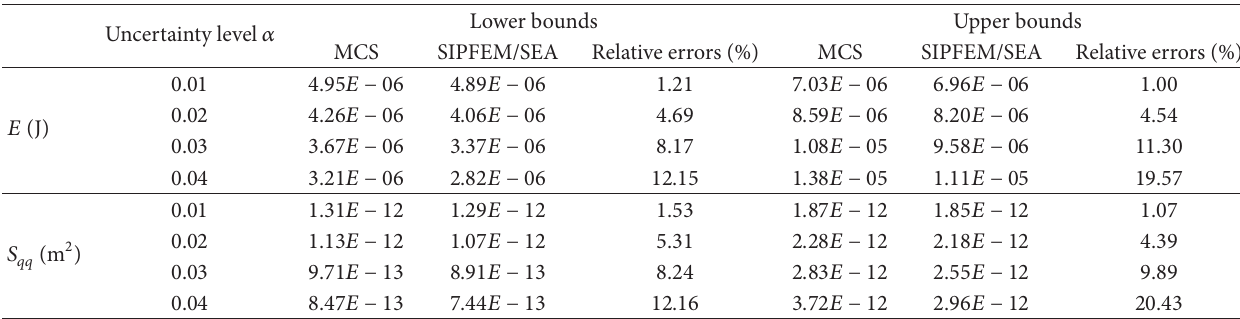
Table 2: The relative errors of the bounds of the plate energy and the autospectrum of the mass displacements for different uncertainty levels ( 𝑓 = 230 Hz).